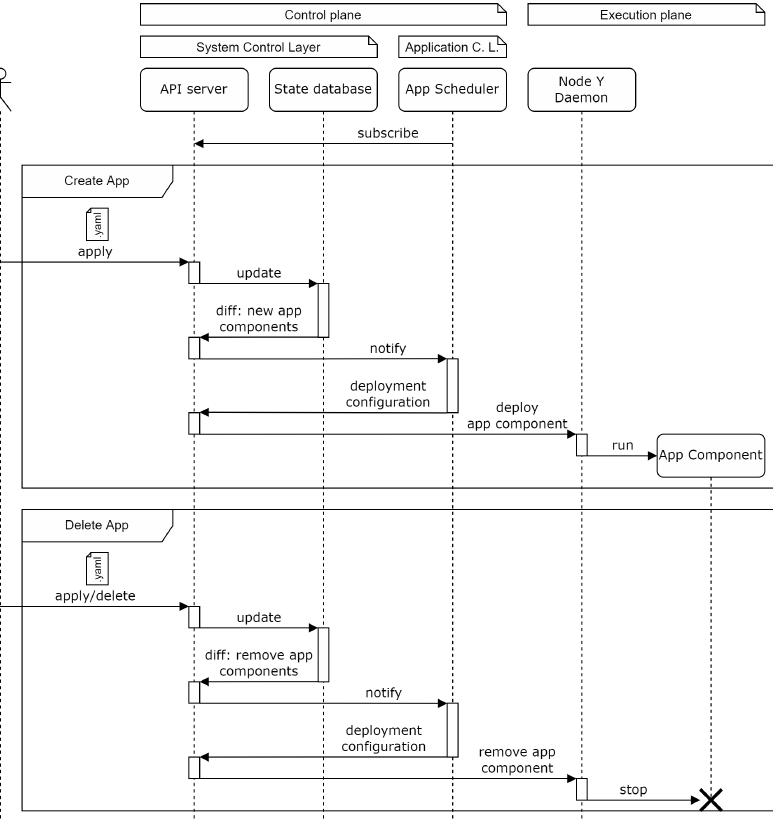
Figure 5. UML sequence diagram for applications’ components